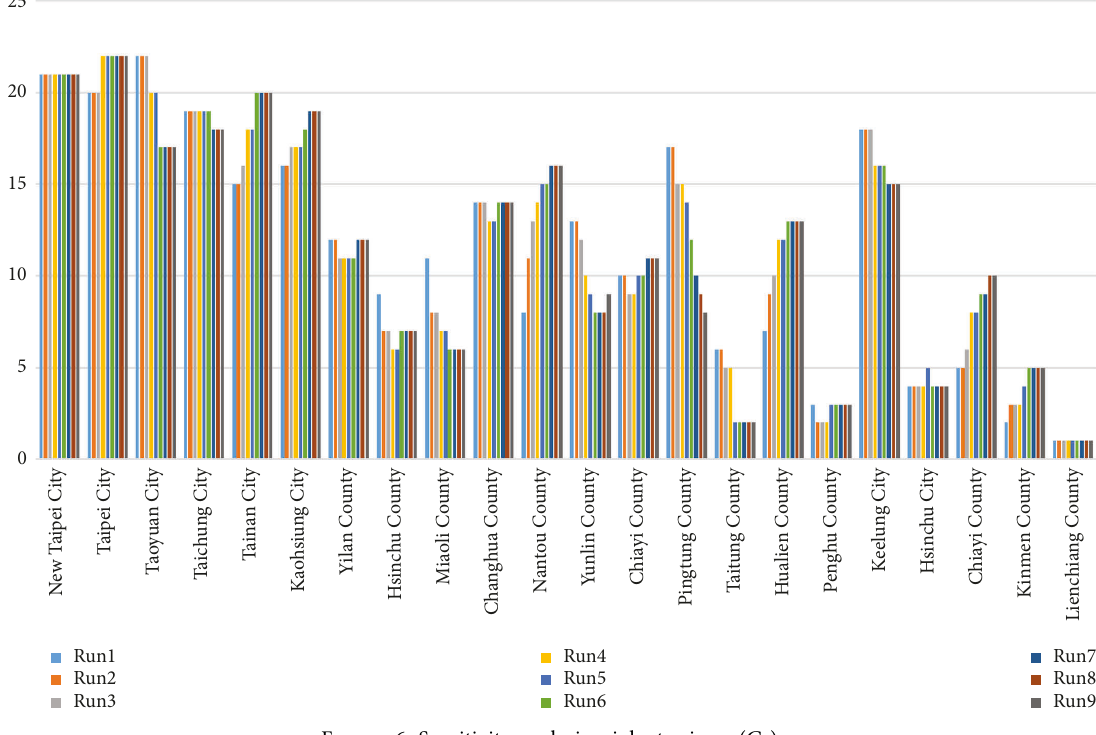
Figure 6: Sensitivity analysis: violent crimes ( C